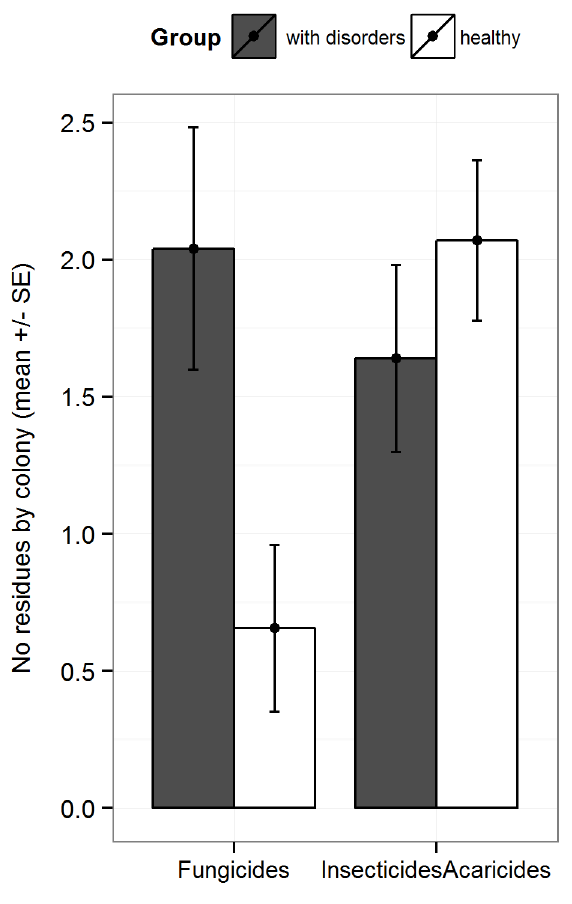
Figure 6. Average number of residues per colony. Data shown for the group with disorders (grey, n=25 colonies) and the healthy ones (white, n=29 colonies). Whiskers show the standard error (SE).